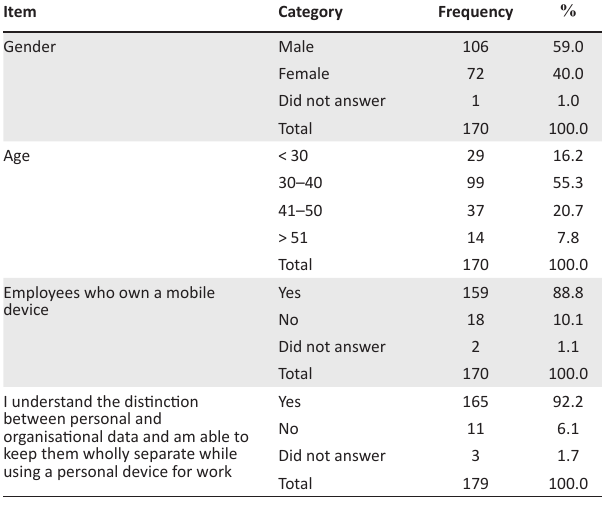
TABLE 1: A demographic profile of the